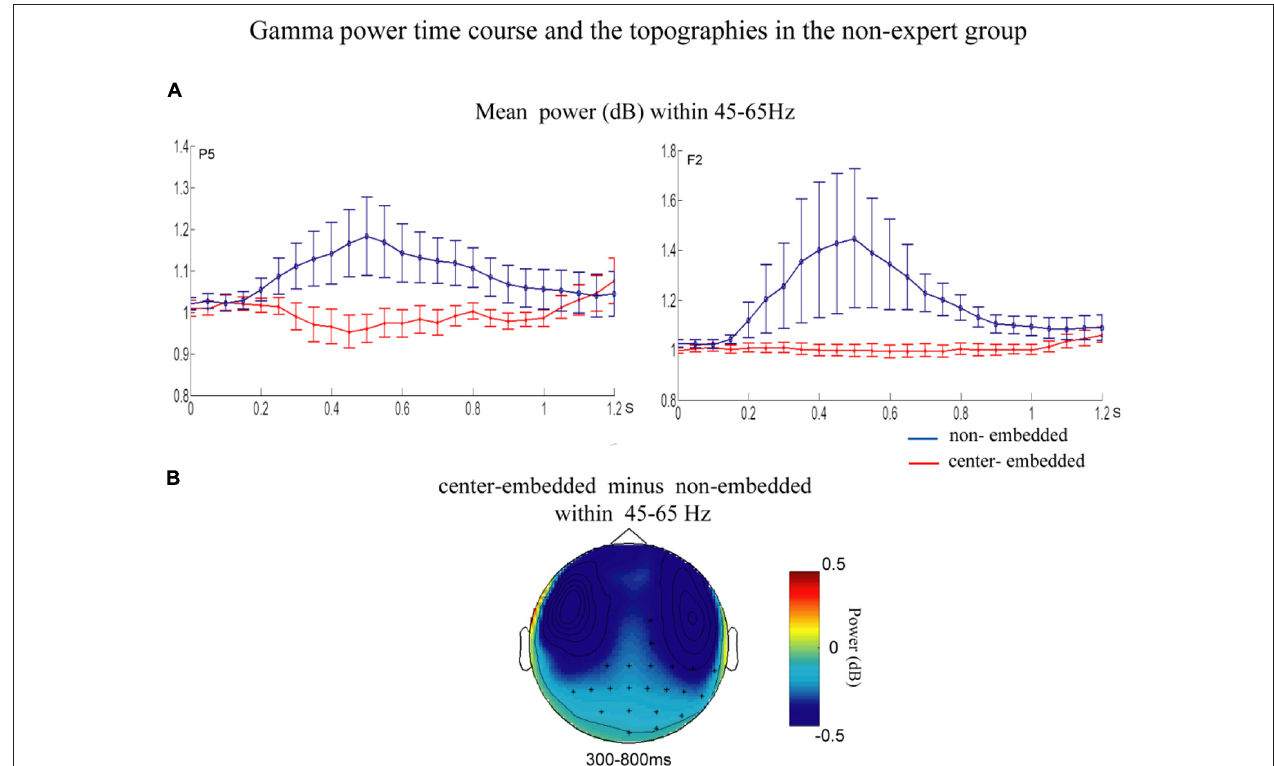
FIGURE 5 | Time course of mean gamma power and difference topographies of final chords in the non-expert group. (A) Temporal course of the mean gamma power (45–65 Hz) between 0 ms and 1200 ms after the onset of the final chords for the non-embedded and center-embedded conditions at electrodes P5 and F2. Error bars indicate standard errors. (B) The difference topographies (center-embedded minus embedded) in the gamma band (45–65 Hz) within 300–800 ms. The electrodes that showed significant effects over 30% of the selected time intervals are marked by